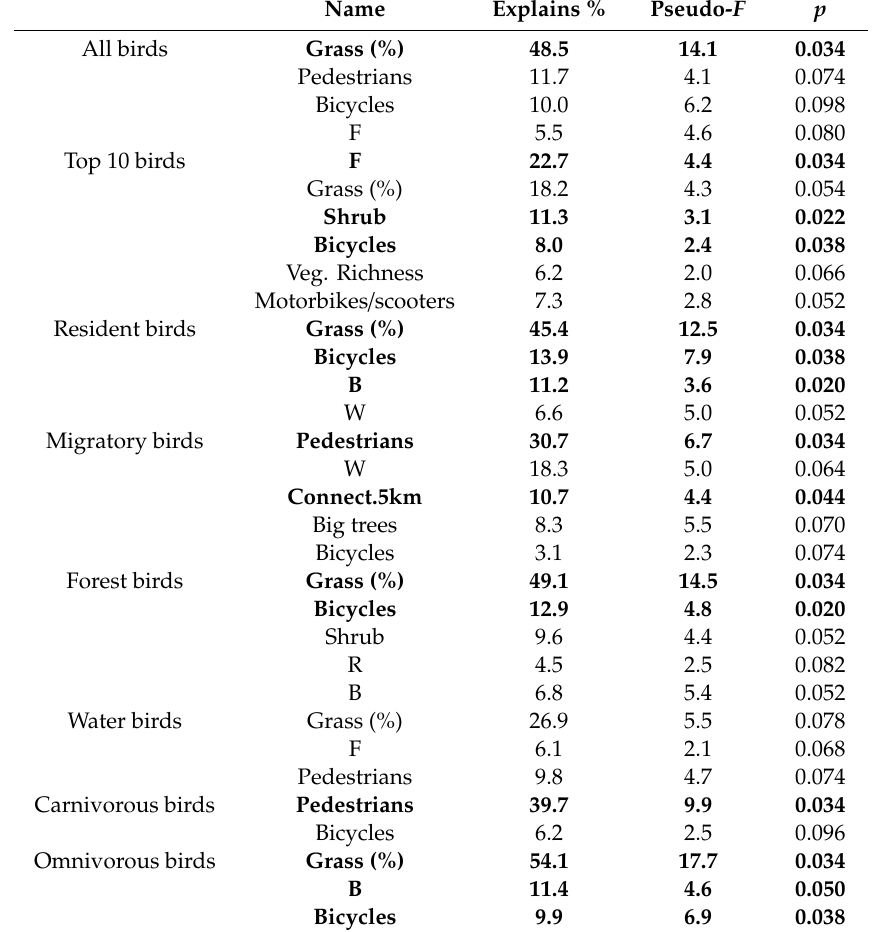
Table 1. Redundancy analysis with biodiversity metrics and influential environmental